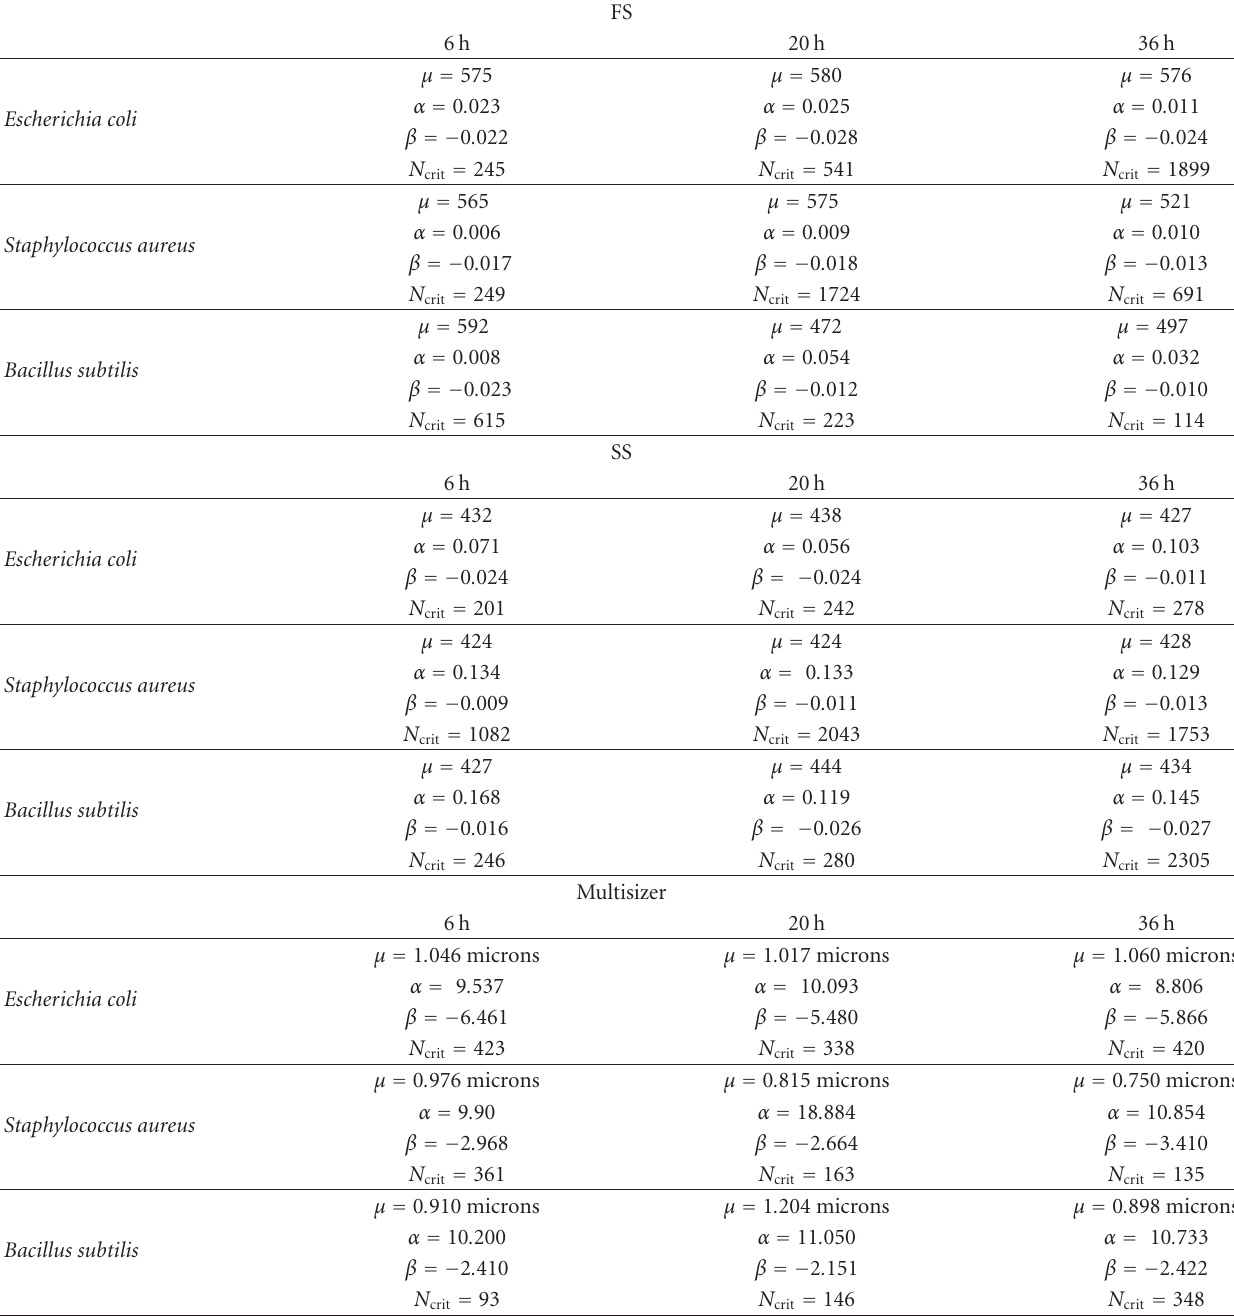
Table 2: Evolution along the incubation time of the μ , α , β , and N crit resulting from the skew-Laplace fit of FS, SS, and Multisizer values (only three microorganisms from Table